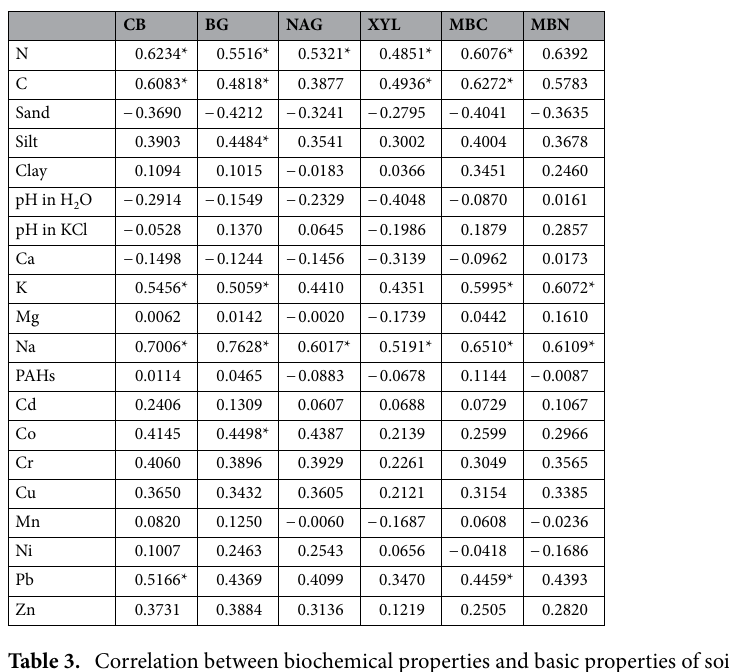
Table 3. Correlation between biochemical properties and basic properties of soils. *p < 0.05.